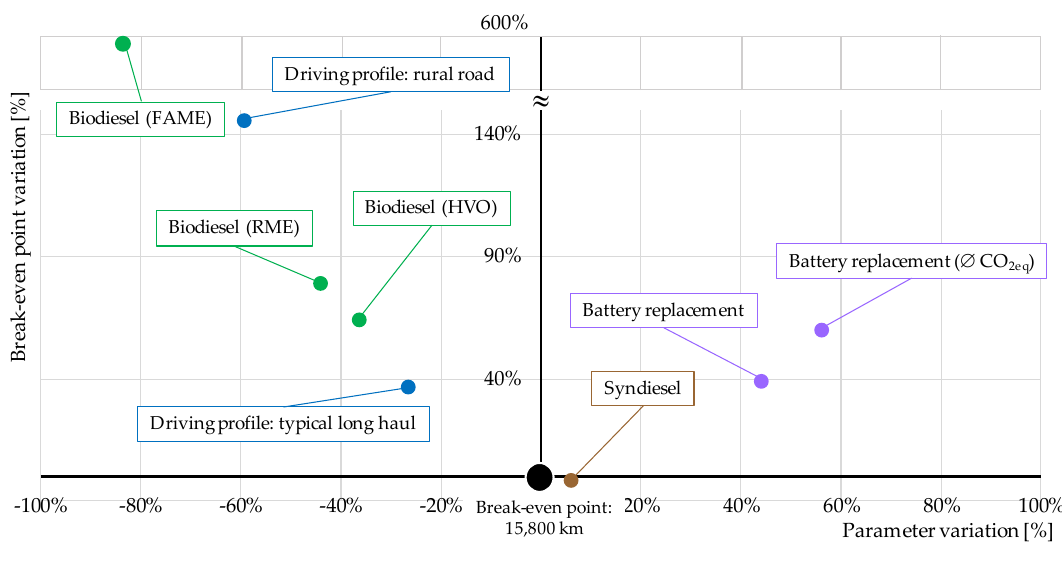
Figure 7. Sensitivity analysis of break-even distance.